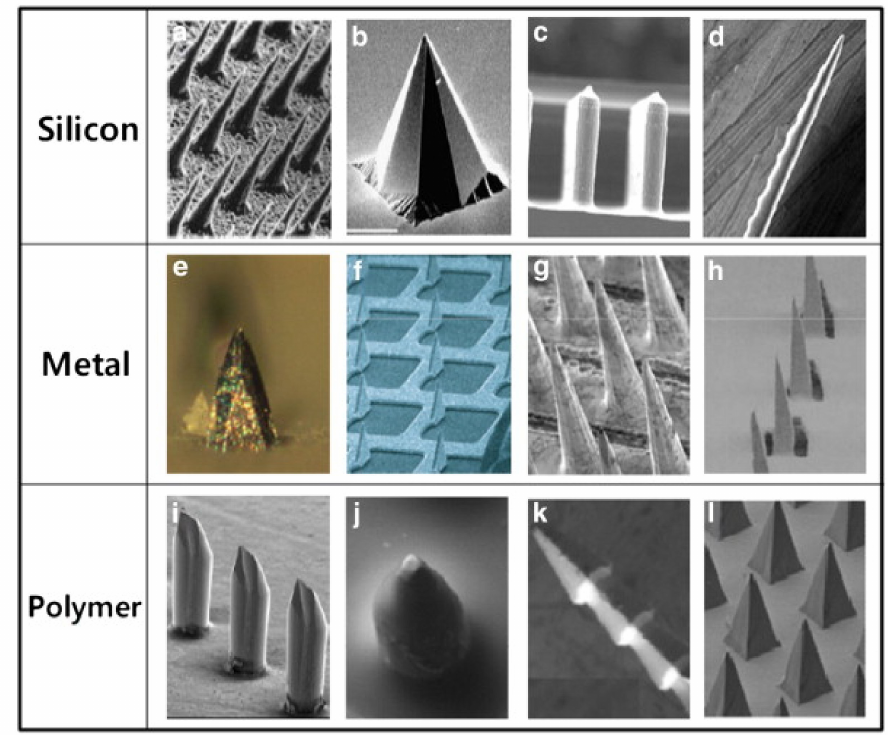
Figure 6. Solid microneedles made of ( a – d ) silicon, ( e – h ) metals and ( i – l ) polymer [41]. Reprinted from Advanced Drug Delivery Reviews, Vol. 64, Yeu-Chun Kim et al., Microneedles for drug and vaccine delivery, Pages 1547–1568, Copyright (2012), with permission from